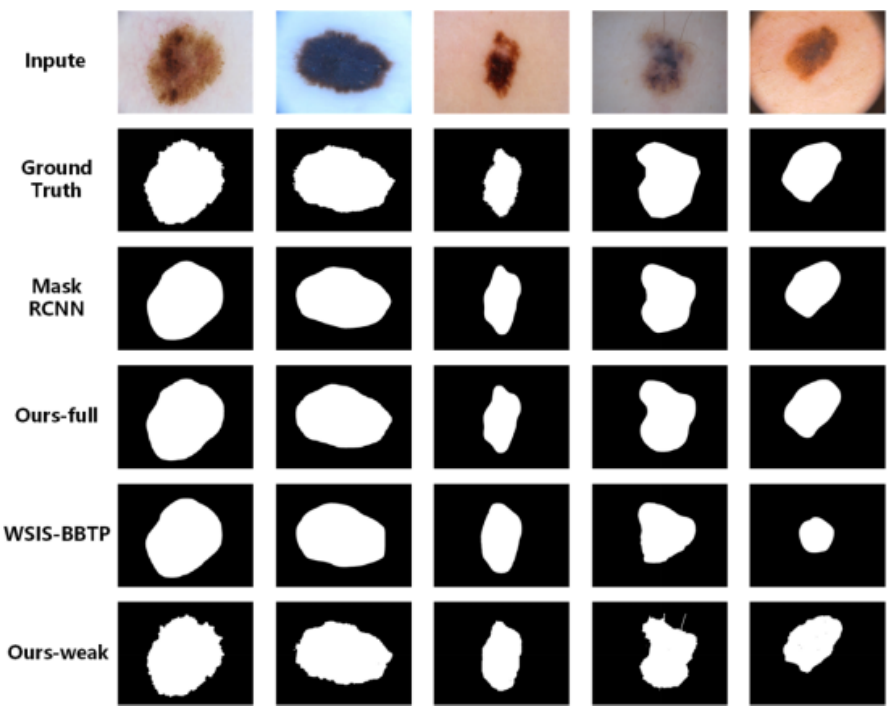
Figure 6. Segmentation results of fully supervised and weakly supervised segmentation methods on the ISIC 2018